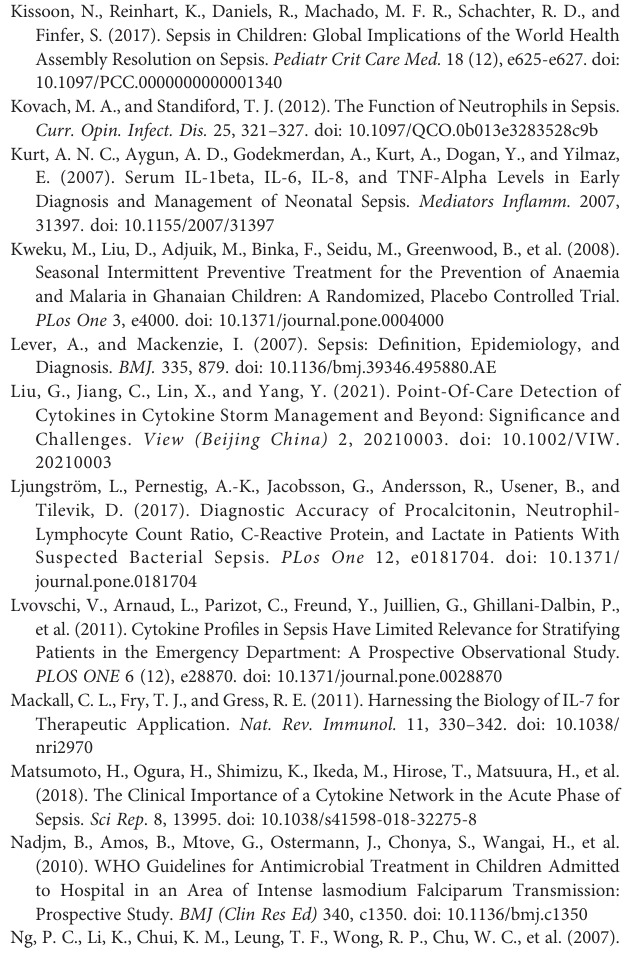
Supplementary Figure 1 | Increased pro-in fl ammatory/anti-in fl ammatory cytokine ratios in children with sepsis compared to clinical malaria. The scatter plots (A – E) show the ratios of the pro-in fl ammatory/anti-in fl ammatory cytokines (IL-2/ IL10,IL-6/IL10,IL-7/IL-10, IL-12/IL-10, IL-17A/IL-10andTNF- a /IL-10)estimatedin